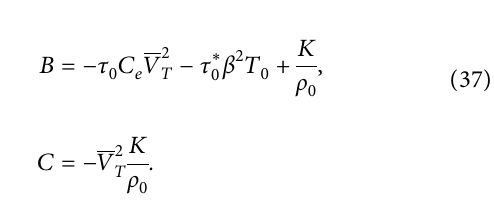
Figure 7: Attenuation coefcient w.r.t. nonlocal parameter e